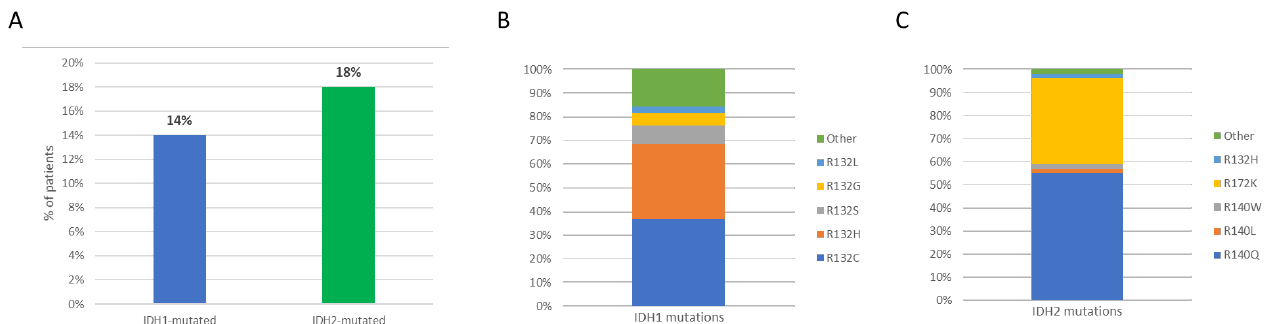
Figure 1. ( A ) Incidence of IDH1 / 2 mutations at AML diagnosis; distribution of IDH1 ( B ) and IDH2 ( C ) mutation